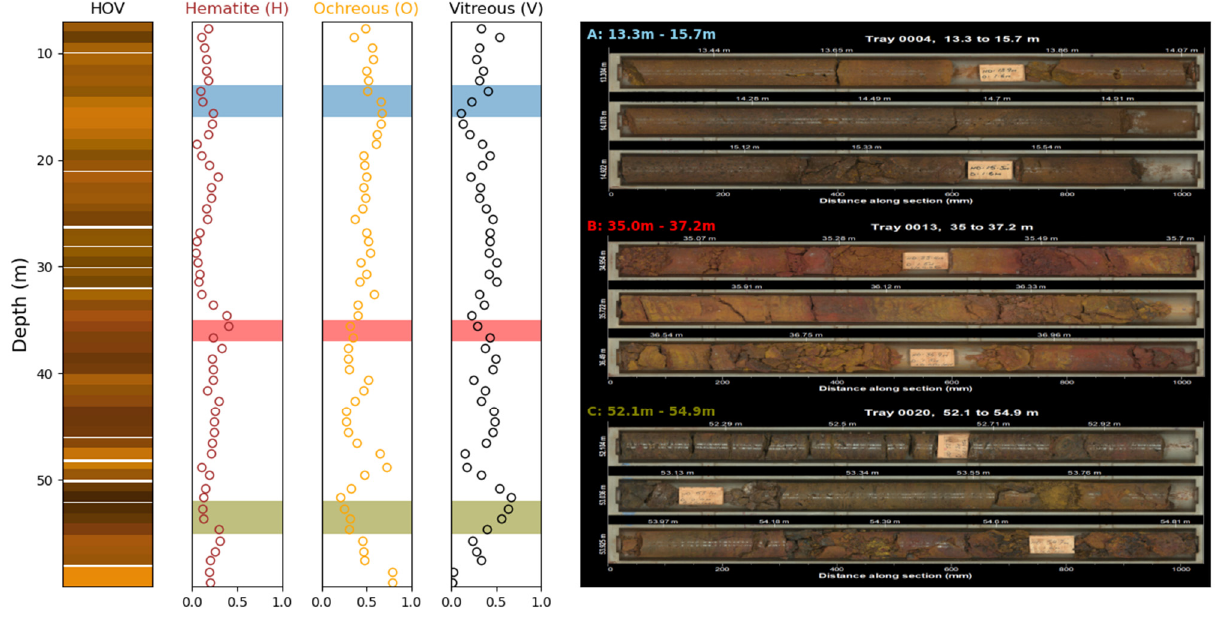
Figure 13. The first column is a false colour image of the downhole estimated mixing ratios where the RGB values are determined from the relevant endmember mixing ratio and are colored as per the mixing ratio columns (columns 2–4) of hematite (brown), ochreous goethite (orange), and vitre- ous goethite (black). In columns 2–4 the mixing ratios are averaged over 1 m for the drillcore and coloured by their respective endmember colours. Column 5 shows colour images of the trays at specific locations in the drill core that show the range of ochreous and vitreous goethite and hema- tite. The depths the core trays span are shown in colored text above each tray with their locations corresponding to the coloured horizontal bar in columns 2–4. Figure 14. ( A ) The false colour iron boomerang for drillcore 2 coloured in the same manner as the downhole plots, ( B ) library selected hematite endmembers, ( C ) library selected ochreous goethite endmembers, and ( D ) library selected vitreous goethite endmembers.